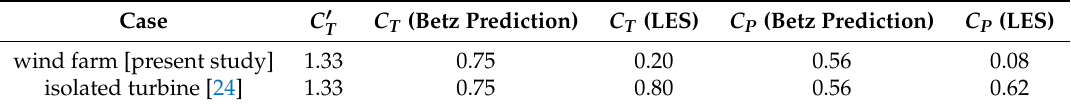
Table 2. C T and C P computed from LES, along with Betz predictions, for isolated actuator disk and = wind farm with C (cid:48) T